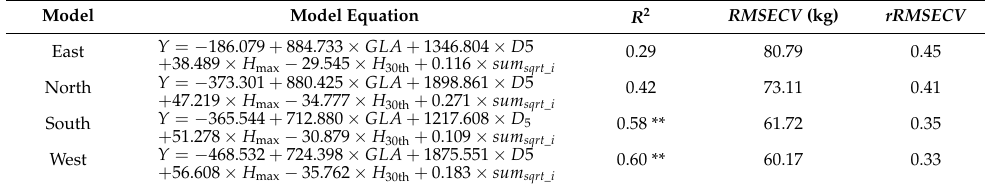
Figure 8. Scatterplots of measured and predicted IT-AGB in different direction. Table 6. Accuracy evaluation of models in different directions.